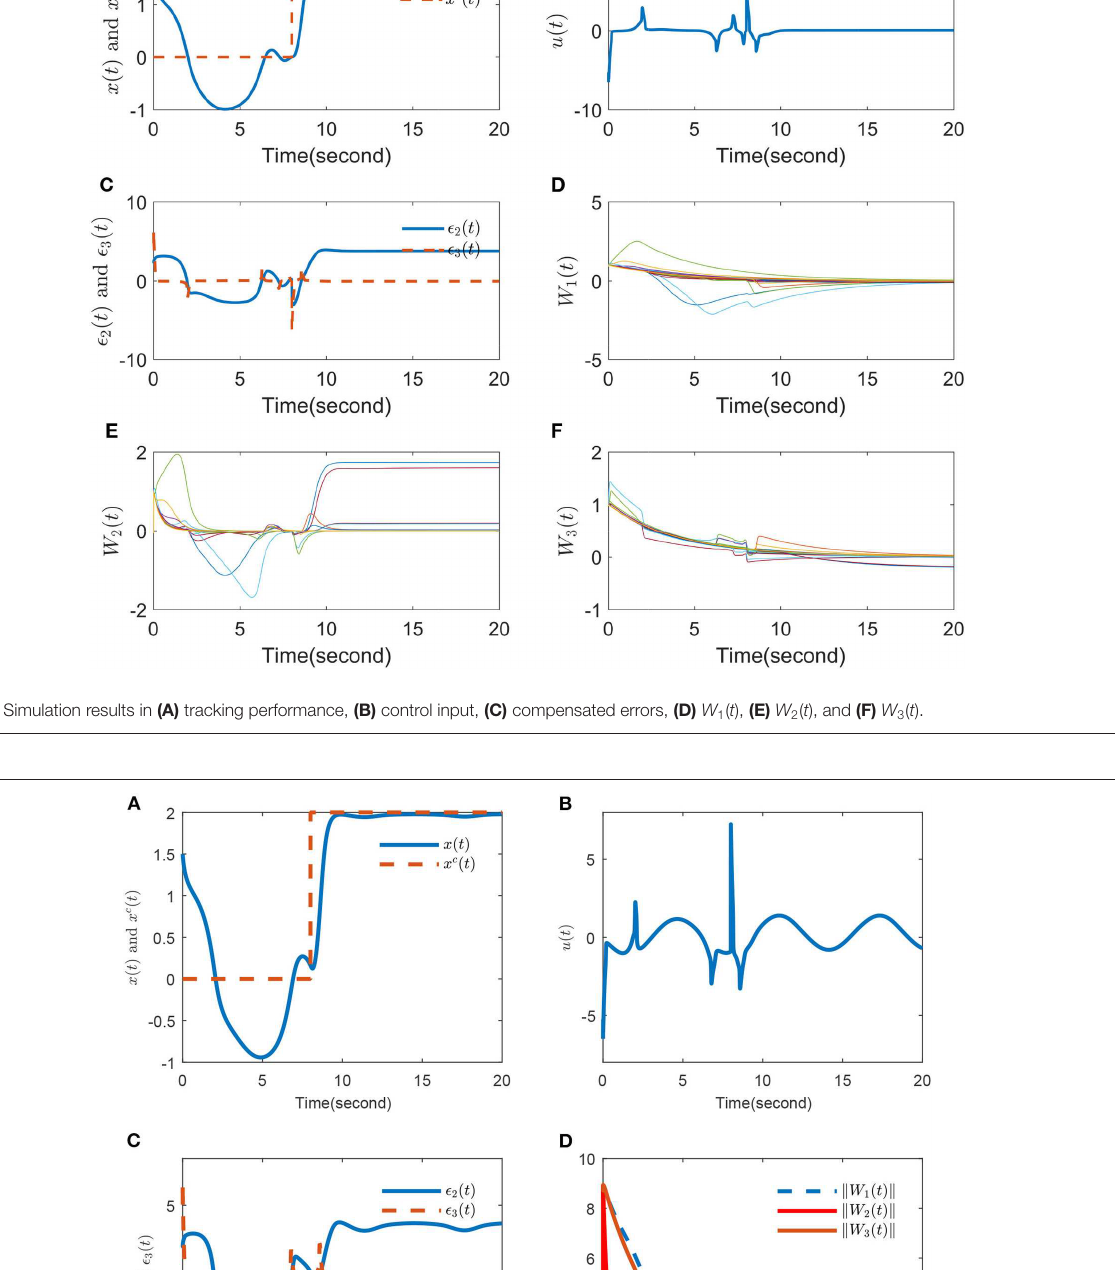
FIGURE 3 | Simulation results with external disturbance in (A) tracking performance, (B) control input, (C) compensated errors, (D)